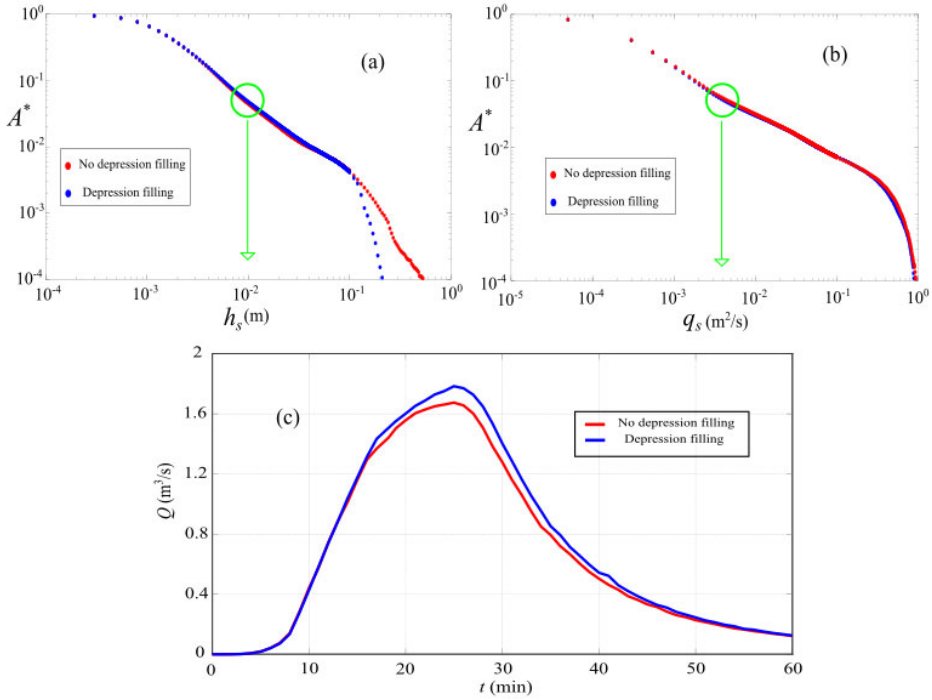
Figure 9. RC1 watershed: effects of the depression filling on both the A* ‐ h s ( a ) and A* ‐ q s ( b ) curves and the simulated discharges ( c ).